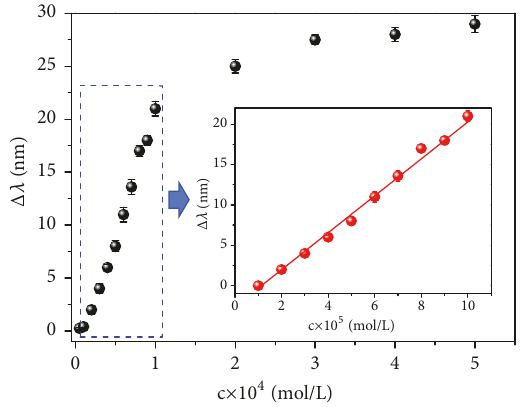
Figure 8: Therelationship between Δ𝜆 and theconcentrationof S 2− . Inset: standard curve of detection of sulfide based on Au-HgNRs sensing